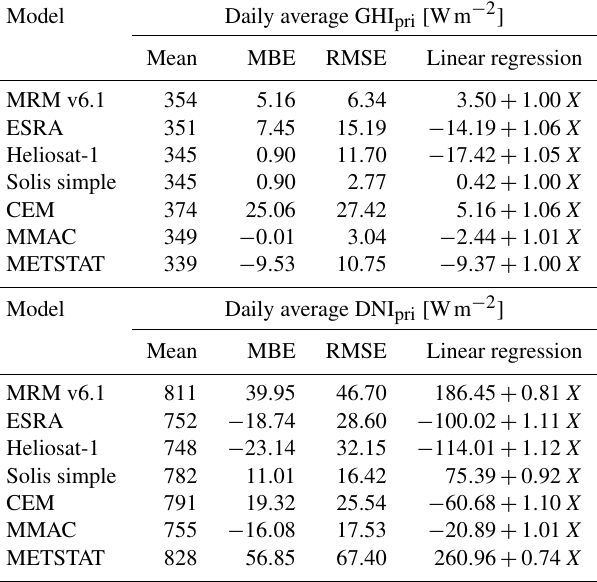
Table 3. Comparison of the annual mean of daily average values of GHI and DNI in pristine (pri) conditions (AOD = 0) simulated with each CSM compared to T–CARS and daily mean GHI and DNI at the surface with aerosols comparing CSM and T–CARS to observa- tions. Note that the number of days available for comparison varies between models. In addition to MBE and RMSE, the linear regres- sion function is shown with reference irradiance simulated with T– CARS denoted as X . The correlation of CSM and T–CARS values are always larger than